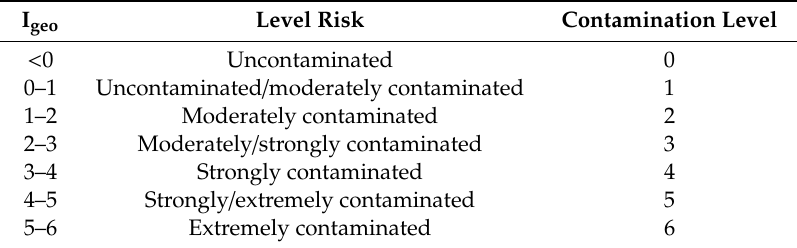
Table 2. The geoaccumulation index range and corresponding contamination level.